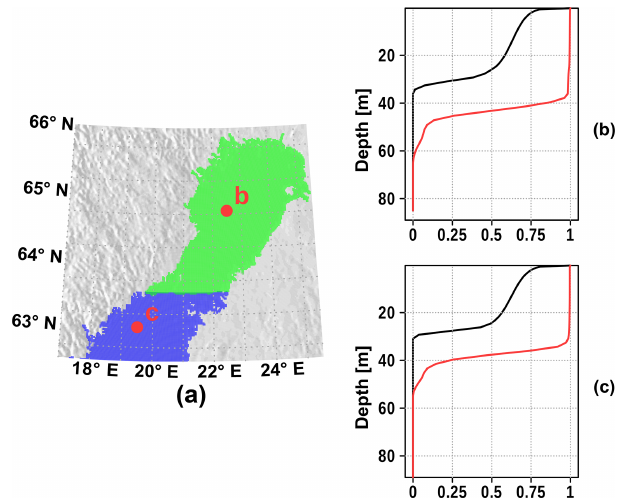
Figure 4. Initializing of the surface tracer in the northern Baltic Sea: horizontal extent (a) of Bothnian Sea surface tracer (blue) and Bothnian Bay surface tracer (green), and vertical extent (b, c) . The vertical profiles after 1d (black) and after 10d (red) are shown.